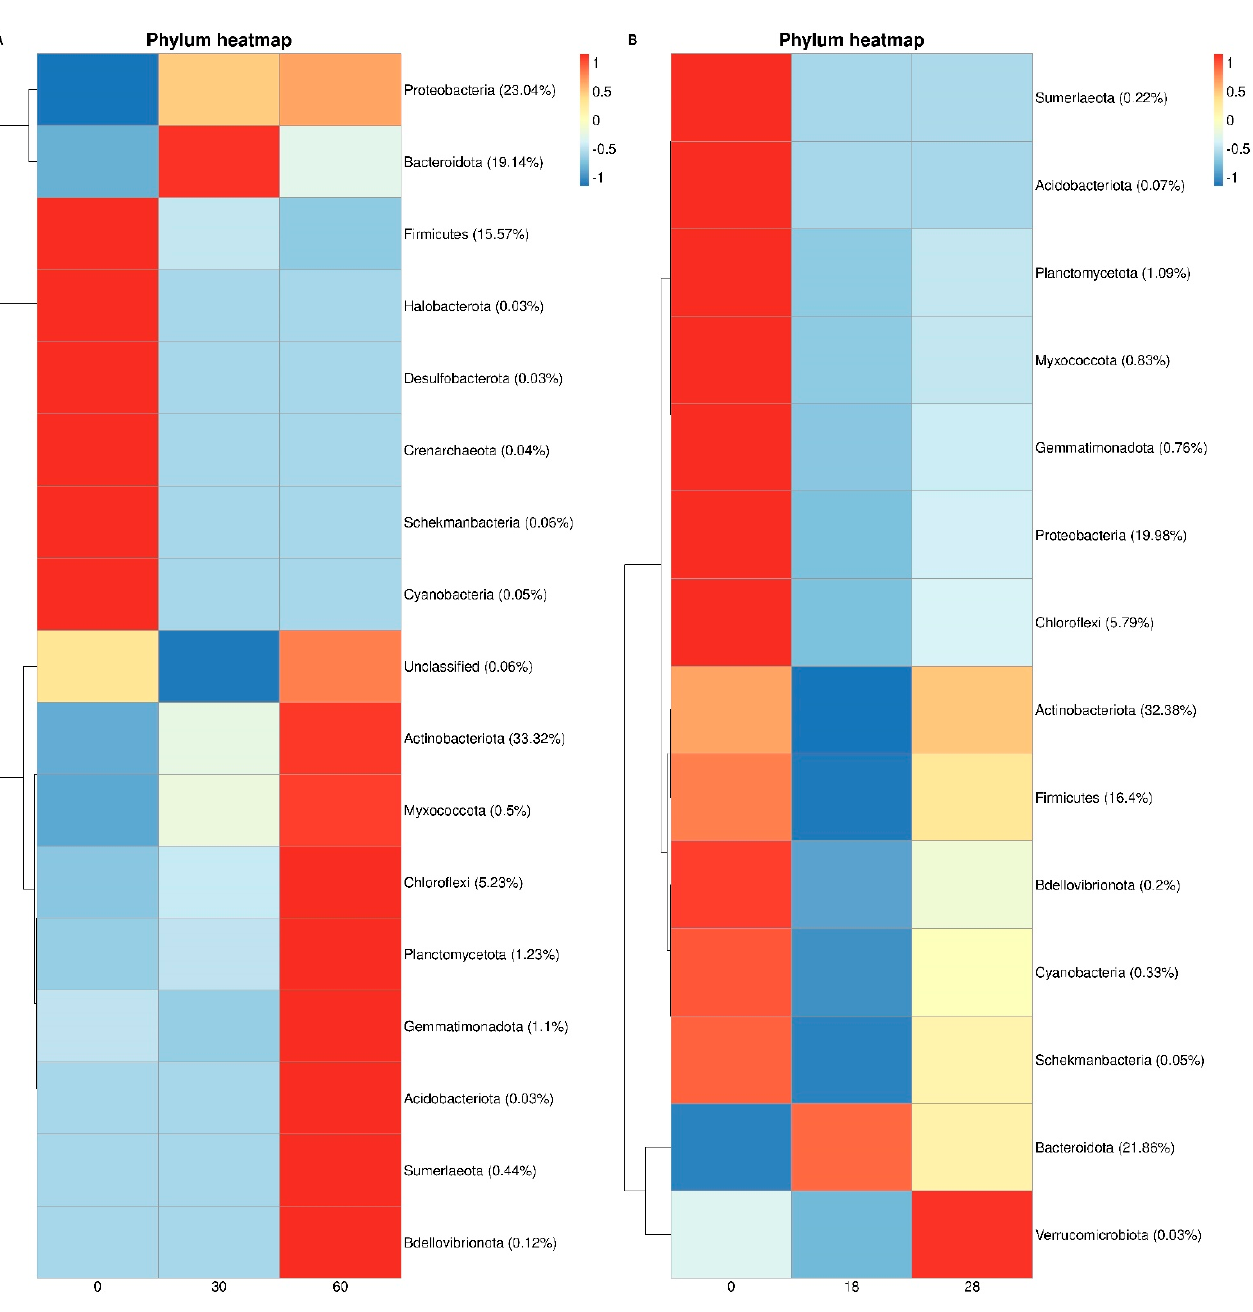
Figure 7. Taxonomic heatmaps at phylum level. Taxonomic heatmaps showing the most abundant ASVs per sample for SMS community ( A ) and Lambertella sp. MUT 5852 community ( B ), agglomerated at phylum level. Percentages reported near ASV names represent the relative abundance of the sum of ASV counts per sample against total sum: a cut-off value of 0.005% was chosen. Hierarchical clustering was performed on rows by Pearson correlation, based on Euclidean distance. In order to evidence variation, a colour scheme that represents row-wise Z-scores of ASV counts per sample was chosen. For this colour scheme, a Z value of 0 matches the reported percentage near ASV name.